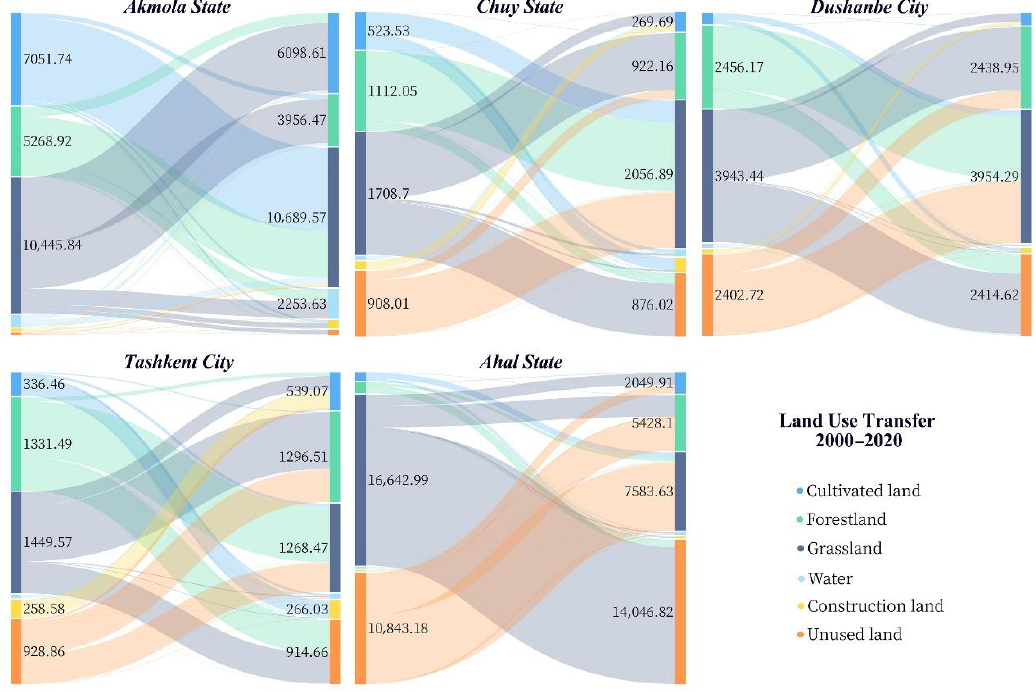
Figure 5. Dynamic degree of land use from 2000 to 2020.